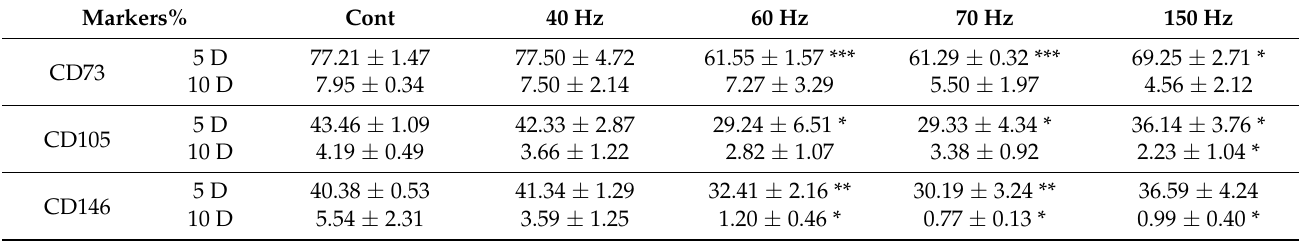
Table 2. FACS analysis of mesenchymal stem cell markers. FACS data percentage—upper values in each row; 5 days of PEMF exposure, lower values in each row; 10 days of PEMF exposure. Cont = control (no PEMF treatment).